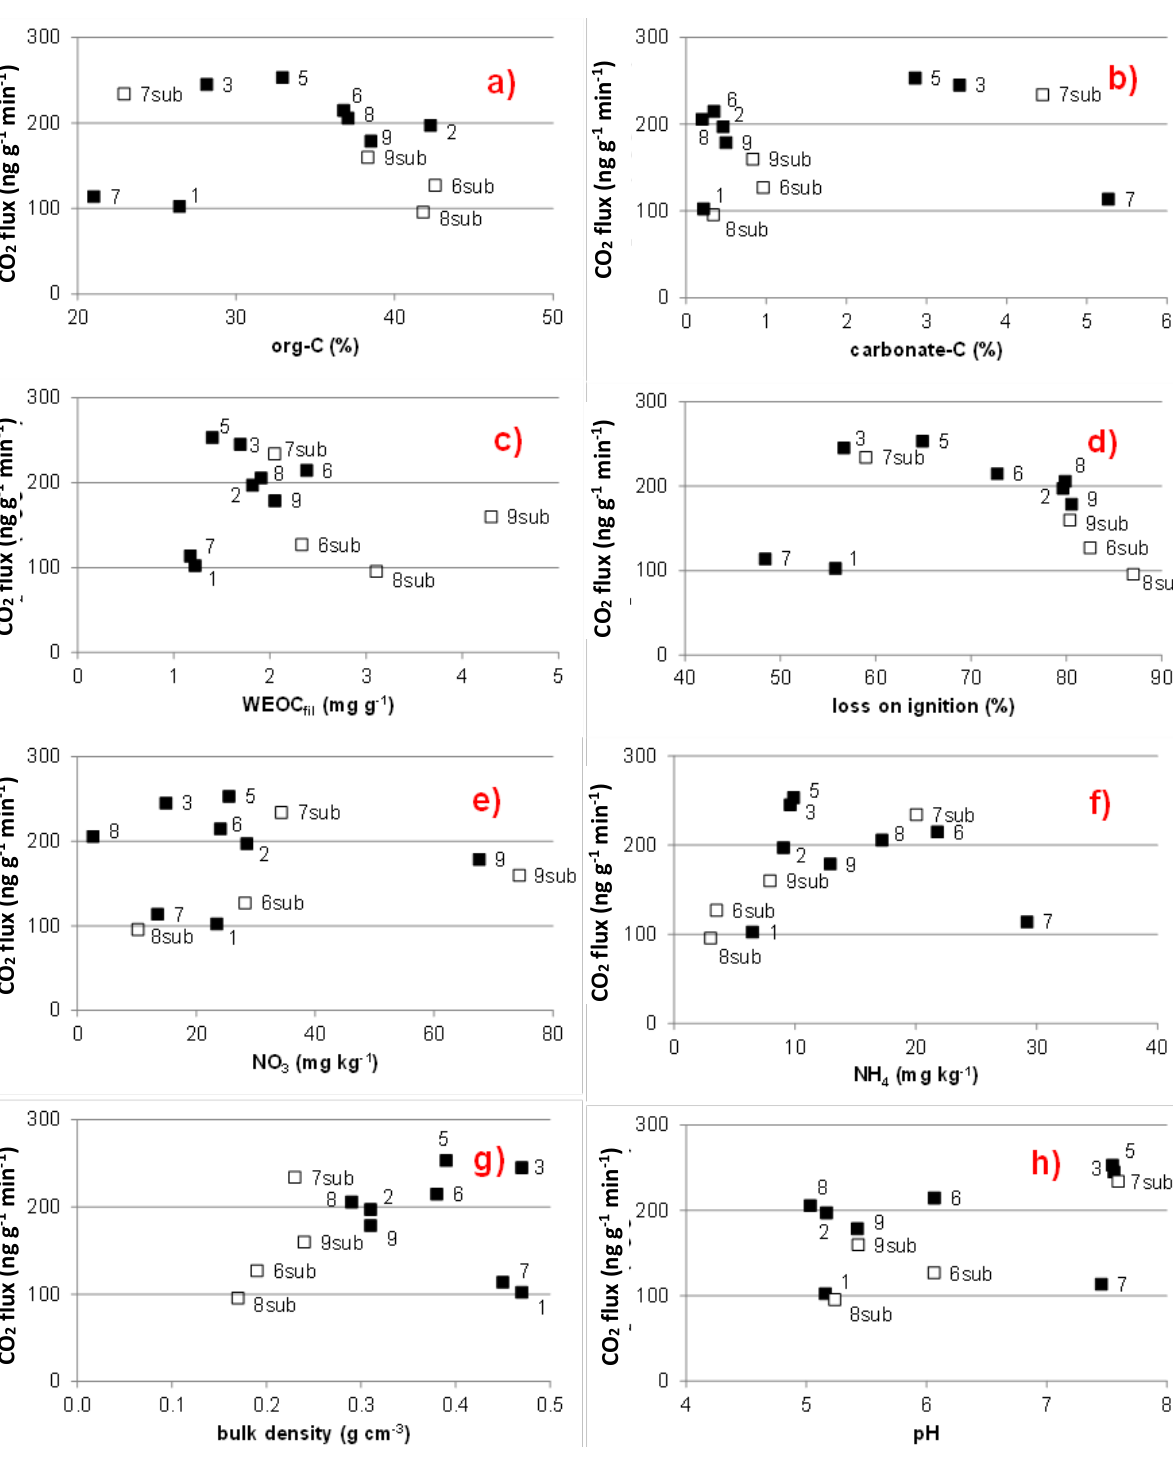
Figure 5. Relationships between carbon dioxide emissions (ng g -1 min -1 , dry mass basis) at a suction head of 1.0 m water column and selected soil factors: a) organic carbon (org-C); b) carbonate carbon (carbonate- C); c) water-extractable organic carbon (WEOC fil ); d) loss on ignition; e) nitrate (NO 3 ); f) ammonium (NH 4 ); g) bulk density; and h) pH. Soil 4 (peaty marl) is not included. Data for topsoils are indicated by filled squares and data for subsoils by open